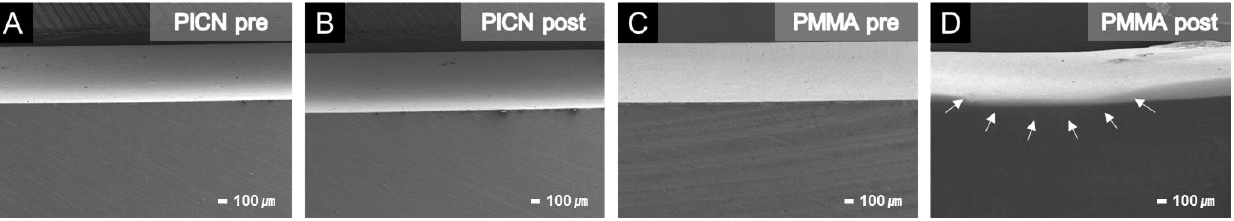
Figure 9. SEM images of cross sections at 35-times magnification. There was no significant change in the surface of PICN between pre and post artificial brushing, whereas PMMA had a concave planar shape after brushing due to abrasion. The arrows in panel D indicate the concave, worn surface of the PMMA specimen. ( A ) PICN pre, ( B ) PICN post, ( C ) PMMA pre, and ( D ) PMMA post.